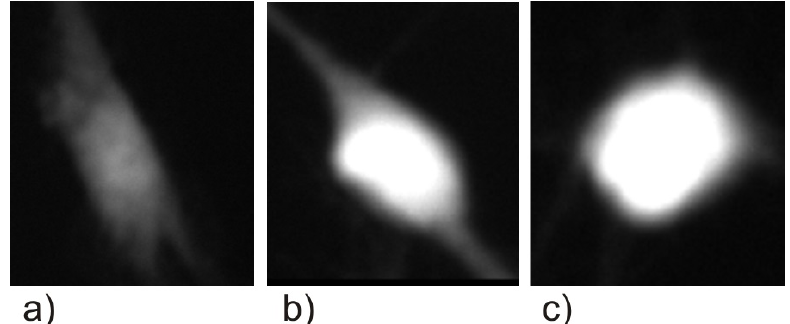
Figure 3. Characteristic morphology changes with TcdB challenge. ( a ) Adherent HFFs without toxin treatment exhibit diffuse cytosolic staining with a cell tracker dye. Upon TcdB treatment, actin cytoskeletal disruption leads to a progression from ( b ) partial to ( c ) complete cell